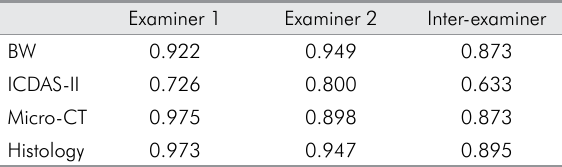
Table 1. Intra- and inter-examiner reliabilities of caries detection methods.